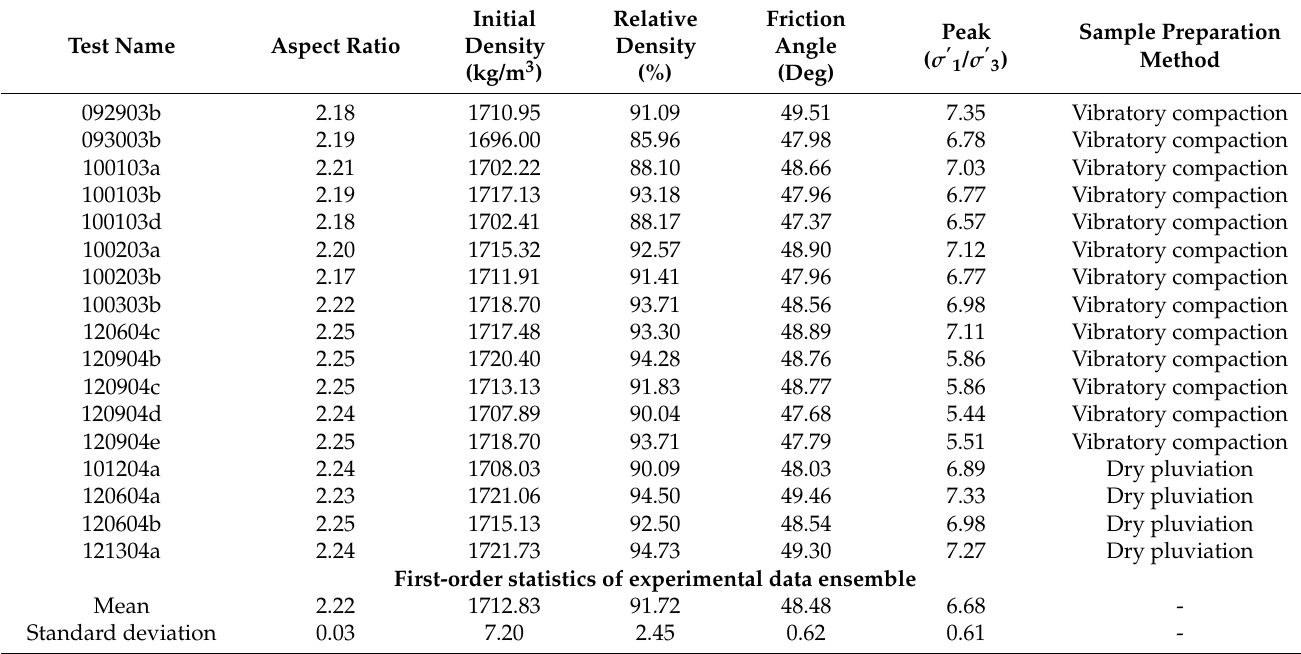
Table 1. Summary of sample